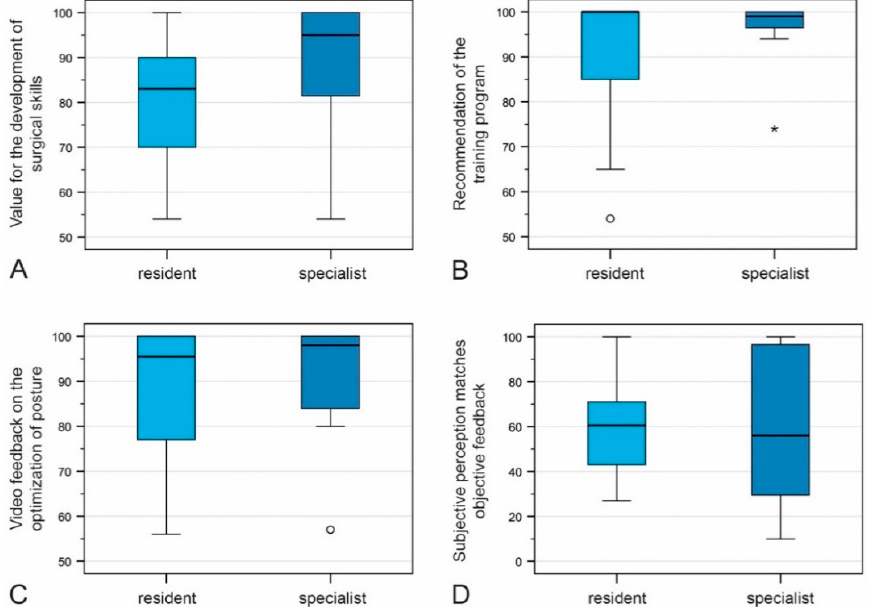
Figure 7. Residents’ and specialists’ assessment of the value of the training course for the develop- ment of surgical skills ( A ), whether they would recommend video feedback training ( B ), whether video feedback helps to optimize their posture ( C ), and whether the attendee’s subjective assessment concurs with the expert’s objective assessment ( D ). Circles and stars represent outliers; the black horizontal line within the box plot is the median.